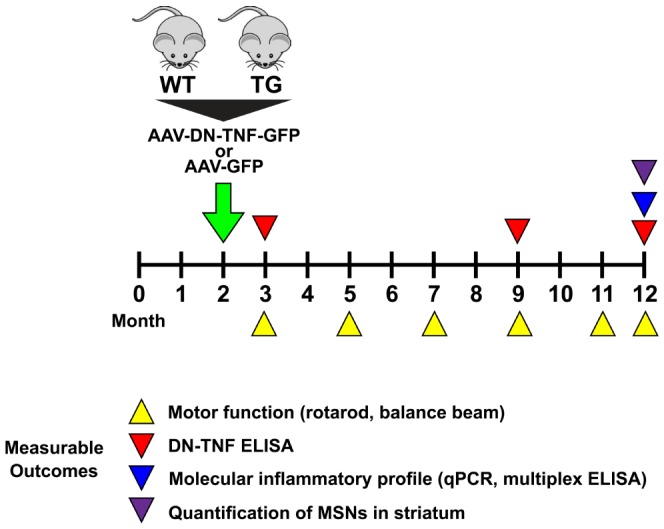
Experimental Design.YAC128 TG and WT male and female mice received injections of AAV-DN-TNF-GFP (GFP is expressed from an IRES) or AAV-GFP (control) in the striatum at 2 months of age (green arrow). A cohort of animals underwent motor function testing on balance beam and rotarod (yellow arrowheads) at 3, 5, 7, 9, 11 and 12 months. Then, medium spiny neurons in the striatum were quantified by unbiased stereology (black arrowhead). At 3, 9 and 12 months of age, additional cohorts of animals were used to measure DN-TNF protein in the striatum by ELISA (red arrowheads) and for analysis of inflammation-related gene expression by qPCR and protein by multiplexed ELISA (blue arrowhead).